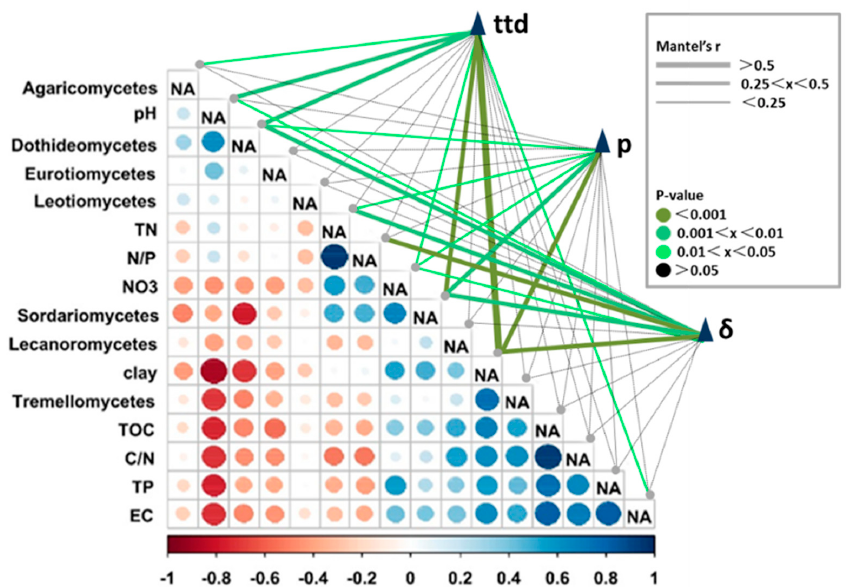
Figure 5. The bottom left diagram showing the Pearson correlation of environmental physicochemical parameters and relative abundances of fungal groups at class levels. A color gradient denotes the Pearson’s correlation coe ffi cients. The upper right graph shows the Mantel test between survival parameters ( ttd , p , and δ ) and the soil properties mentioned above. EC, electrical conductivity; TOC, water-soluble organic carbon; TN, total soluble nitrogen; NH 4 -N, ammonium nitrogen; NO 3 -N, nitrate nitrogen; TP, total dissolved phosphorus; clay(%), soil clay content.